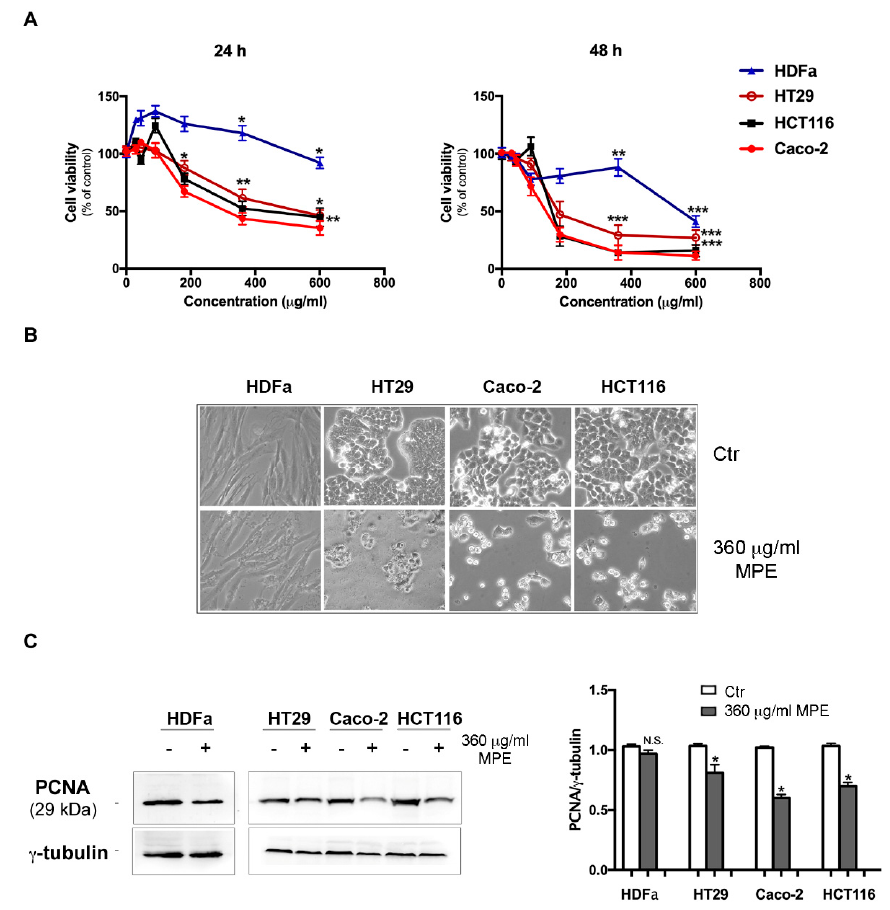
Figure 2. MPE effects on cell viability and the level of proliferation marker proliferating cell nuclear antigen (PCNA) in human dermal fibroblasts and colon cancer cell lines. ( A ) Human dermal fibroblasts (HDFa) and colon cancer cells (HT29, Caco-2 and HCT116) were incubated in the presence of different concentrations of MPE for 24 and 48 h as reported in the Materials and Methods section.